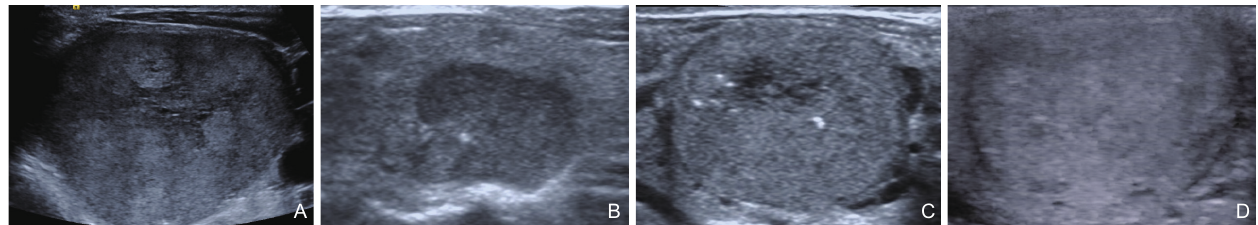
Figure 3 Conventional ultrasound features of FAs and FTCs. (A) Transverse sonography of the left thyroid from a 71-year-oldman with widely invasive FTC.A round shape(55×58mm) was shown; (B) Longitudinal sonography of the left thyroid from a 40-year-oldman with minimally invasive FTC. The halo sign was not observed; (C) Longitudinal sonography of the left thyroid from an81-year-oldwoman with widely invasive FTC. The calcifications were shown; (D) Longitudinal sonography of the left thyroid from a 35-year-old woman with FA. An isoechoic oval solid nodule with halo sign without calcifications was shown.